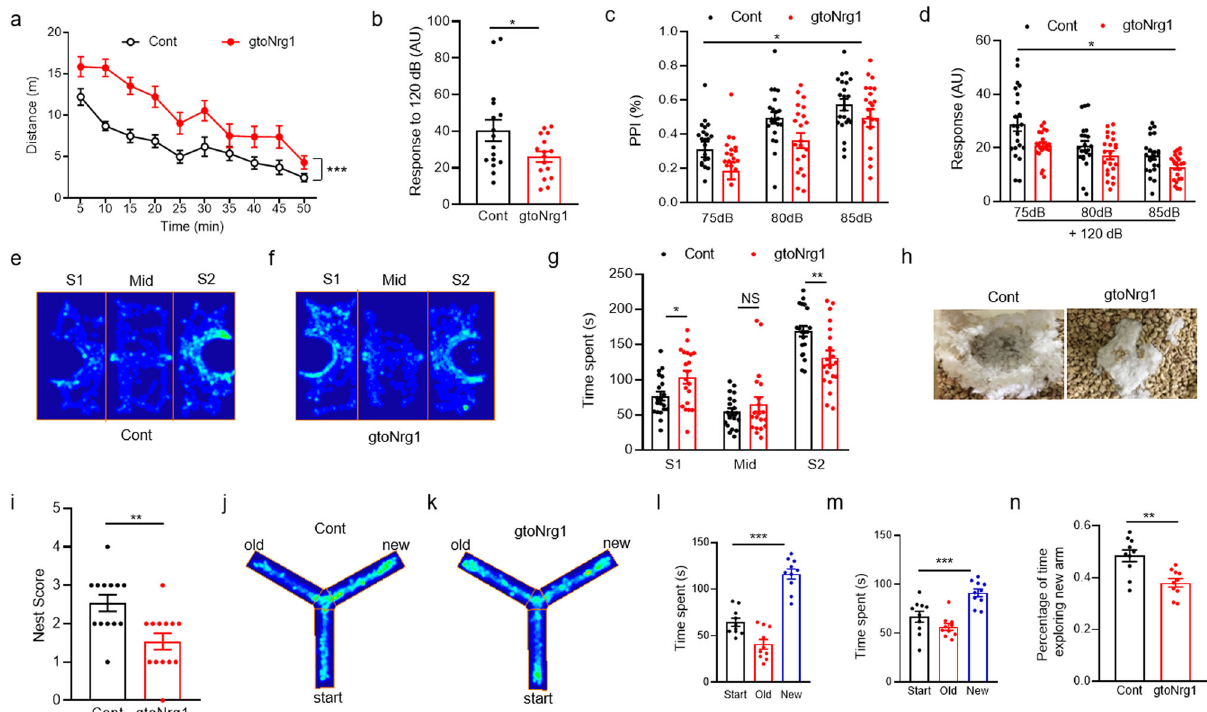
Fig. 2 Behavioral de fi cits in gto Nrg1 mice. a Travel distance in open fi eld was increased in gto Nrg1 mice compared with controls. ***Genotype F (1, 28) = 15.74, P = 0.0005, two-way ANOVA, n = 15 for each group. Data are presented as mean values + / − SEM. b Reduced startle response to 120 dB noise in gto Nrg1 mice compared with controls. * P = 0.0356, two-sided t test, n = 16 for each group. Data are presented as mean values + / − SEM. c Impaired PPI in gto Nrg1 mice compared with controls. *Genotype F (1, 42) = 4.9, P = 0.0324, two-way ANOVA, n = 22 for each group. Data are presented as mean values + / − SEM. d Reduced re fl ex amplitudes on prepulse + pulse trials in gto Nrg1 mice compared with controls. *Genotype F (1, 42) = 6.11, P = 0.0176, ***Prepulse F (1.709, 71.78) = 53.69, P < 0.0001, *Interaction (prepulse × genotype) F (2, 84) = 3.136, P = 0.0486, two-way ANOVA, n = 22 for each group. Data are presented as mean values + / − SEM. e , f Occupancy plot of the heads from control ( e ) and gto Nrg1 ( f ) mice in the three-chamber test. S1, familiar mouse; S2, novel mouse. g Reduced social novelty in gto Nrg1 mice compared with controls. Time spent in each chamber was quanti fi ed. NS not signi fi cant, * P = 0.02, ** P = 0.0056, two-sided t test, n = 20 for each group. Data are presented as mean values + / − SEM. h , i Impaired nest building in gto Nrg1 mice compared with controls. h Representative images for a nest built after 12 h. i Quanti fi cation of nest score. ** P = 0.0031, two-sided t test, n = 13 for each group. Data are presented as mean values + / − SEM. j , k Occupancy plot of the heads from control ( j ) and gto Nrg1 ( k ) mice in Y maze. l , m Preference for the new arm in control ( l ) and gto Nrg1 ( m ) mice. The time exploring the start, old, and new arms was quanti fi ed. *** P < 0.001, one-way ANOVA, n = 10 for each group. Data are presented as mean values + / − SEM. n Impaired spatial recognition memory in gto Nrg1 mice compared with controls. The percentage of time exploring a new arm in the Y maze was quanti fi ed. ** P = 0.0016, two-sided t test, n = 10 for each group. Data are presented as mean values + / −